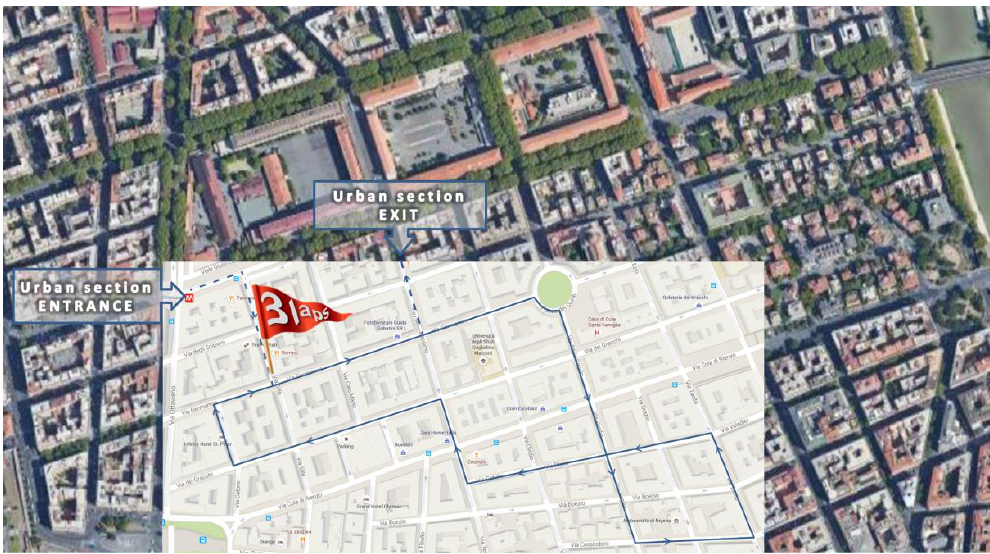
ffi c density Figure 3. Urban with low traffic density section. Figure 3. Urban with low tra Figure 3. Urban with low traffic density section.